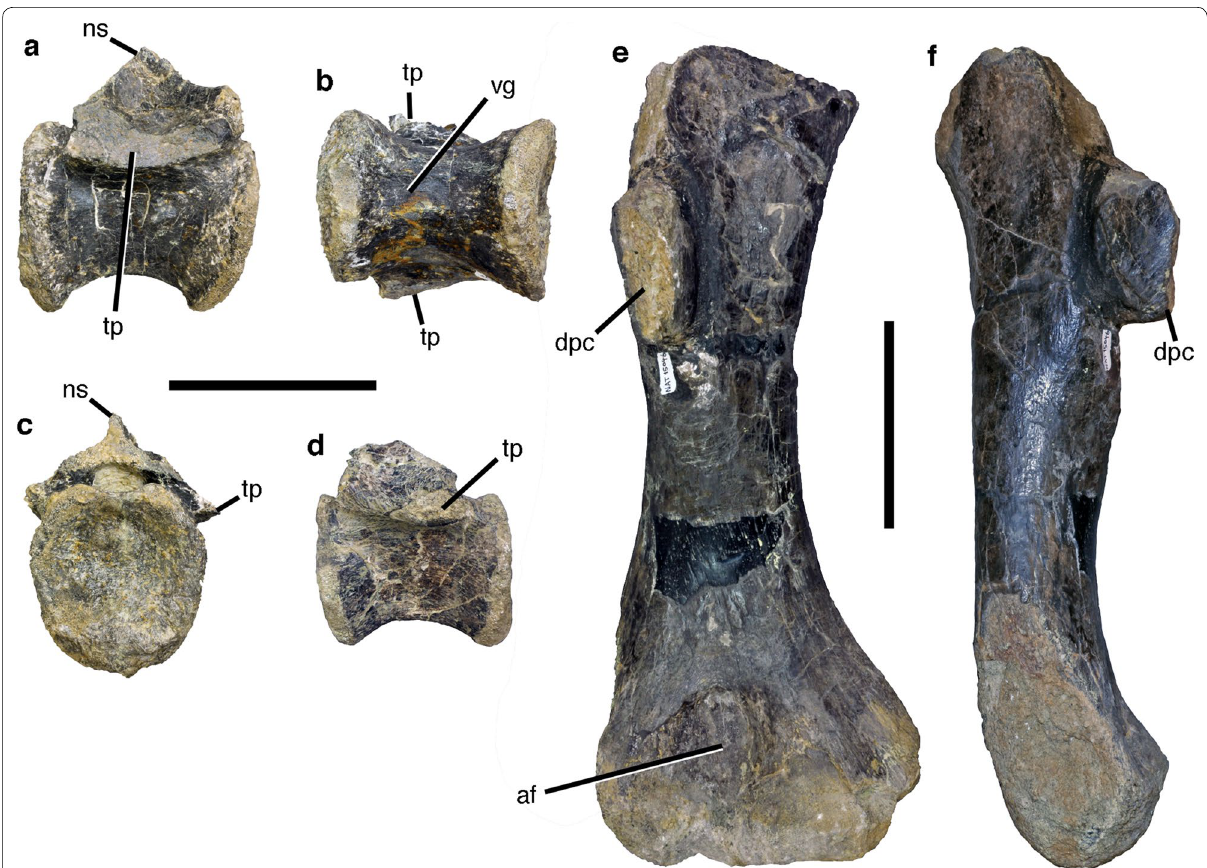
Fig. 12 Material from the locality Schleitheim-Santierge in the MzA, tentatively referred to Schleitheimia schutzi n. gen., n. sp. a-c Mid-caudal vertebra, MzA NAT15047, in right lateral ( a ), ventral ( b ) and posterior ( c ) view; d posterior mid-caudal vertebra, MzA NAT15048, in left lateral view; e , f partial right humerus, MzA NAT15046, in anterior ( e ) and lateral ( f ) view. af, anterior fossa; dpc, deltopectoral crest; ns, neural spine; tp, transverse process; vg, ventral groove. Scale bars equal 10